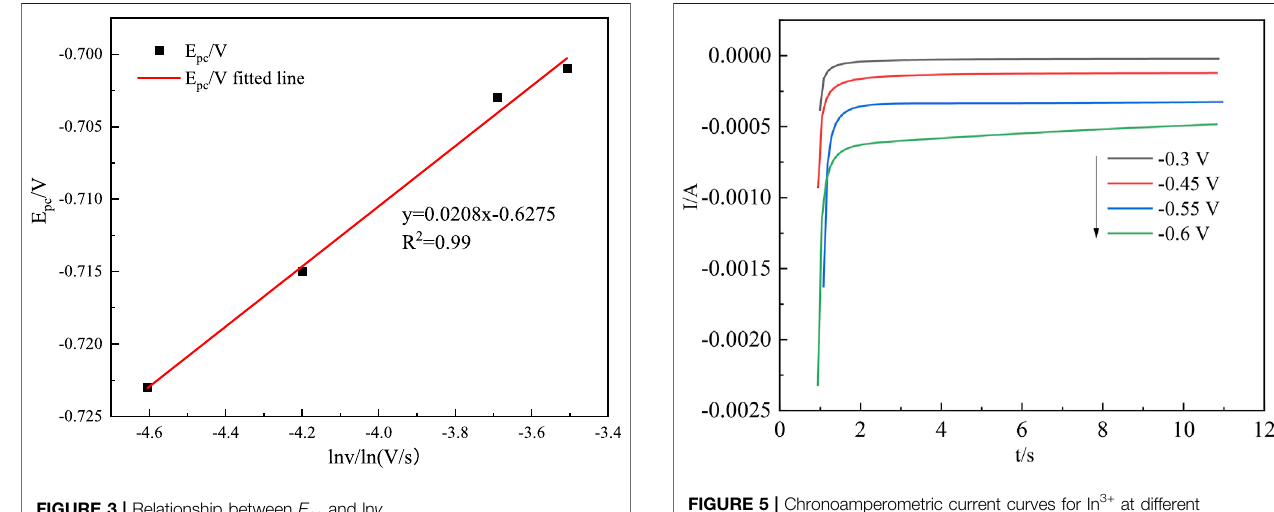
FIGURE 3 | Relationship between E pc and ln v .